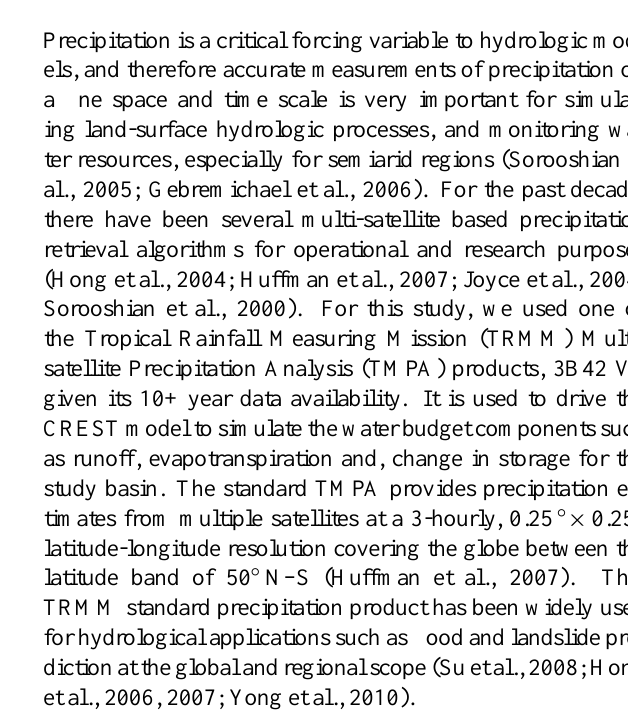
Fig. 2. (a) Nzoia basin average daily rainfall and discharge time series. (b) Cumulative distribution plot of observed basin average rainfall (mmday − 1 ) for